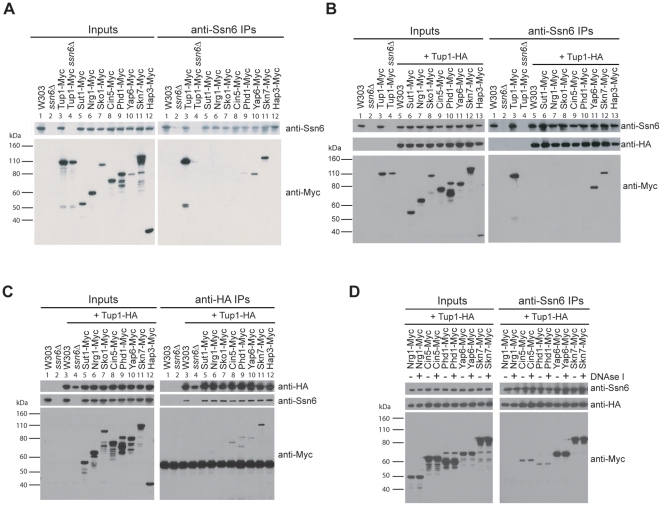
Candidate recruiters physically interact with Tup1-Ssn6.Strains carrying Myc-tagged candidate recruiters (Cin5, Phd1, Yap6, or Skn7), previously characterized recruiters (Sut1, Nrg1, or Sko1), or a protein that was not predicted to interact with Tup1 (Hap3) were immunoprecipitated with anti-Ssn6 antibodies (A and B), or with anti-HA antibodies (to immunoprecipitate HA-tagged Tup1) (C). Inputs (left) and immunoprecipitated material (right) were immunoblotted with anti-Ssn6 antibody, anti-HA antibody (to detect Tup1), or anti-MYC (to detect recruiter proteins). (D) The interactions between Tup1-Ssn6 and predicted recruiters are not mediated by DNA. Strains carrying a Myc-tagged characterized recruiter (Nrg1) or predicted recruiters (Cin5, Phd1, Yap6, or Skn7) were immunoprecipitated with anti-Ssn6 antibodies in the presence (+) or absence (−) of DNAse I. Inputs (left) and immunoprecipitated material (right) were immunoblotted with anti-Ssn6 antibody (top), anti-HA antibody (middle) or anti-MYC (bottom).